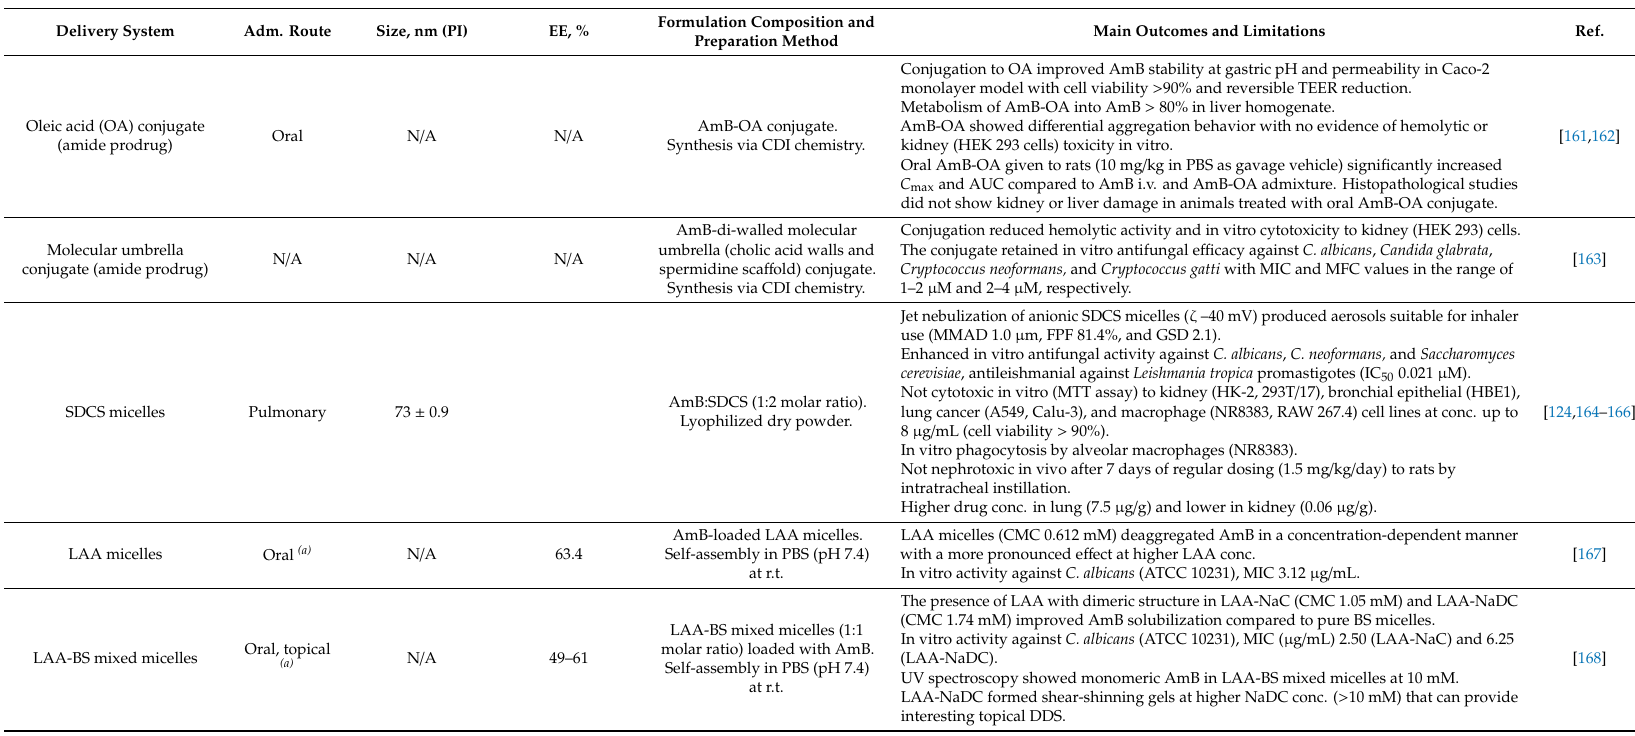
Table 2. Lipid-based systems for delivery of amphotericin B currently under